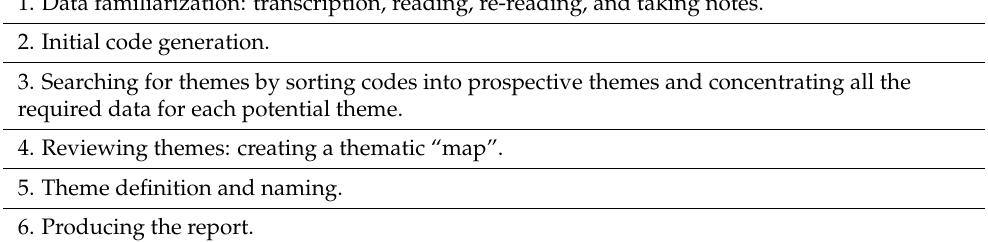
Table 1. Six steps for the thematic analysis